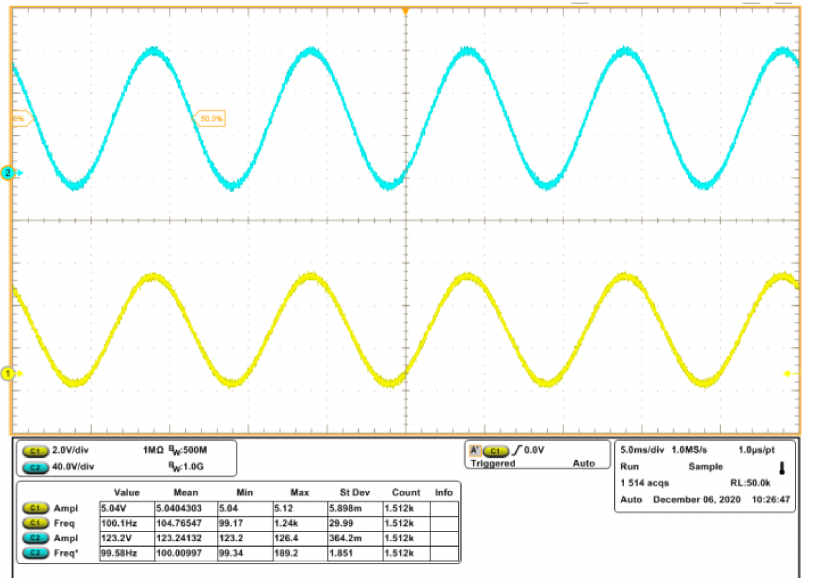
Figure 26. Measured sinusoidal input–output waveforms for the power amplifier using general operational